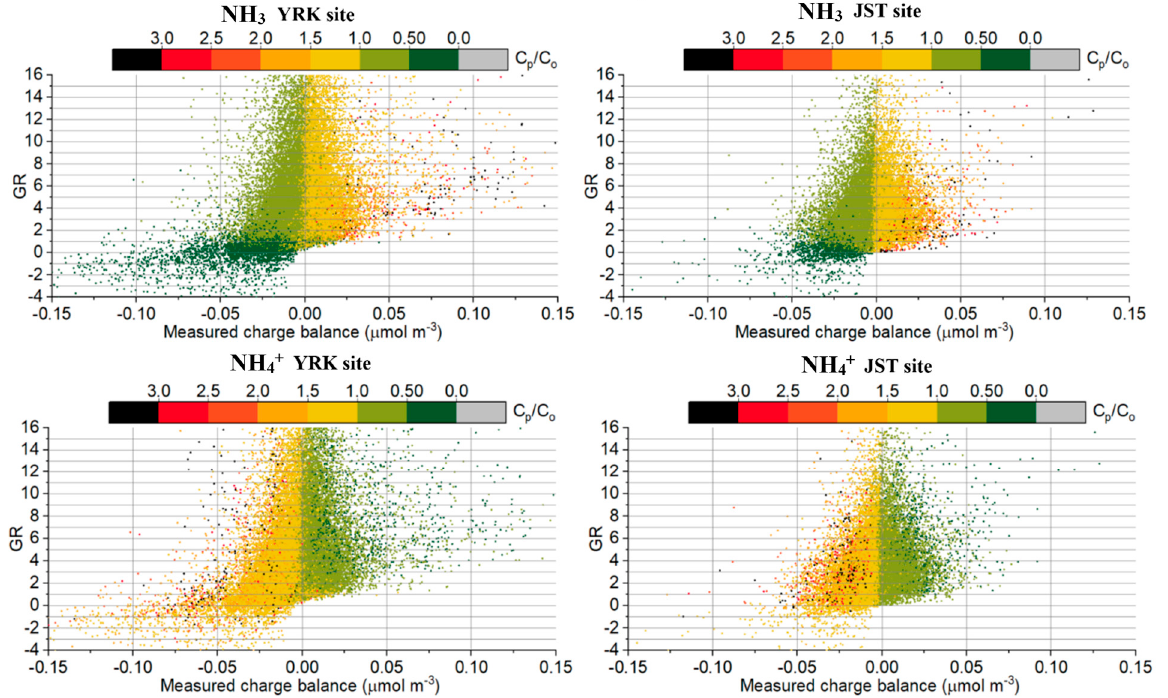
Figure 9. The ratios of prediction over observation for NH 3 and NH 4 + using stable setup at the YRK and JST sites.